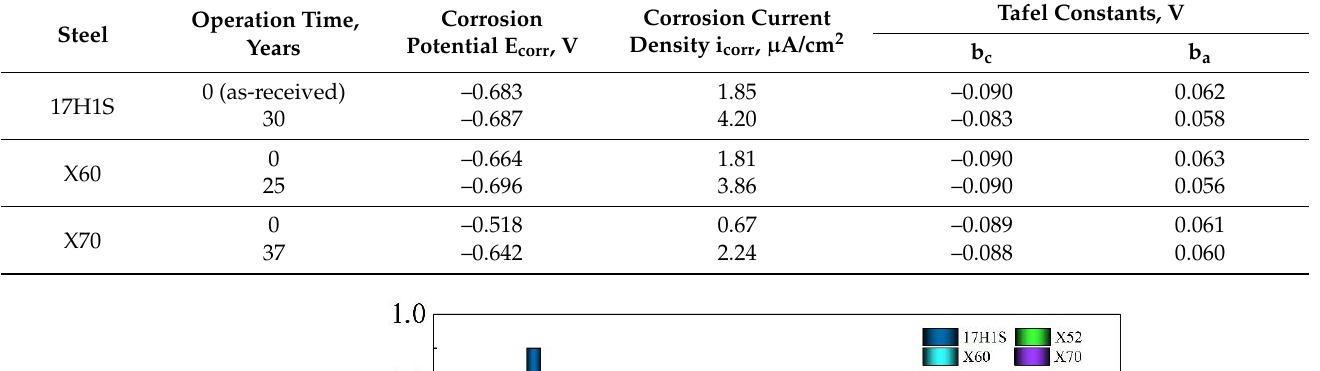
Table 3. Basic electrochemical parameters of pipe steels measured in NS4 solution as a simulated soil solution. Steel